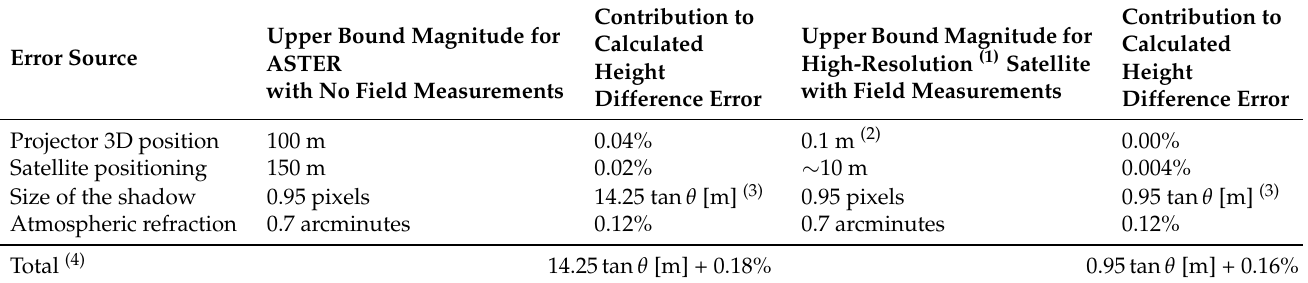
Table 1. A priori error breakdown by source for two different platforms. Errors expressed as a percentage are relative to the absolute value of the measured height